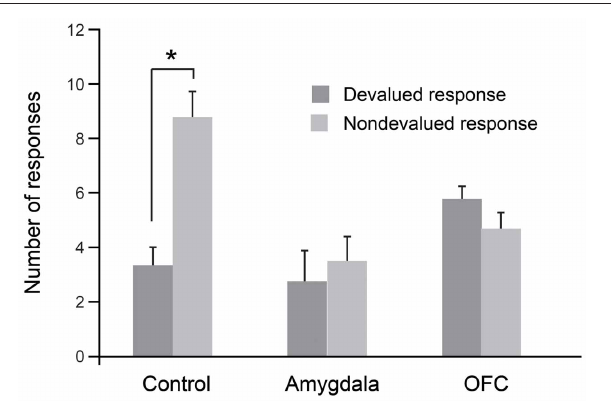
FIGURE 4 | Choices between objects associated with food vs. fluid resources. On each trial, monkeys were allowed to choose among objects associated with food or fluid reward and a third, nonreinforced object. Only objects associated with food reward were baited when monkeys were hungry, and only those objects associated with fluid were baited when monkeys were thirsty. Curves show scores for sessions involving object choices when monkeys were either hungry (food) or thirsty (fluid). Amygdala lesions had no effect on learning rates in this task. Modified from Rhodes et al.